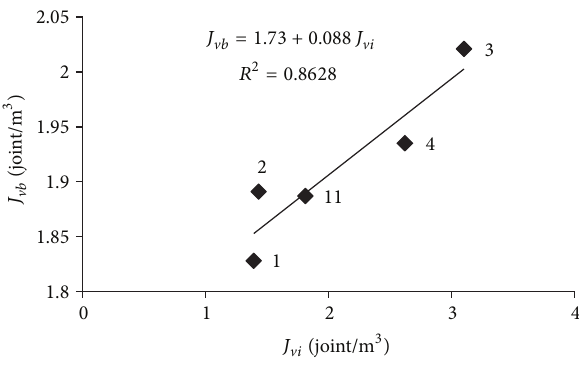
Figure 8: Relationship between the mean in-situ volumetric joint count (𝐽 V 𝑖 ) and the mean volumes of the blocks (𝑉 𝑏 ) produced in the Karaburun limestone quarries.